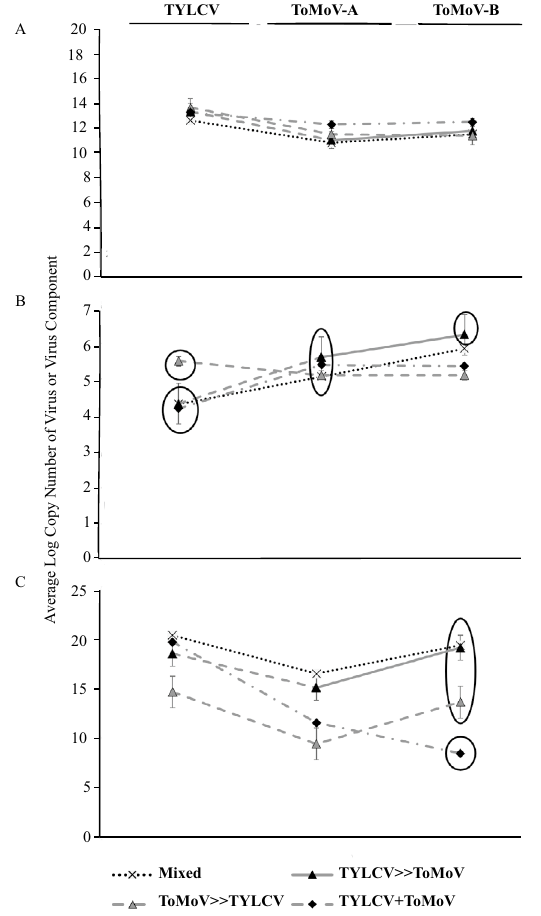
Figure 2. The average log 10 copy number of TYLCV, ToMoV-A, and ToMoV-B in co-acquisition scenario treatments. Data were analyzed separately for samples in which both TYLCV and ToMoV were detected in ( A ) vector cohorts, ( B ) artificial diet viruliferous vector cohorts fed upon, and ( C ) co-infected plants inoculated with vector cohorts. Copy numbers were compared for the main effects of virus acquisition scenario treatment, virus or viral component, and their interaction term; averages from interaction term main effects are shown. LS means comparisons were conducted using Tukey’s method at P = 0.05. Circled averages are not significantly different from each other by virus/viral component; no circles indicate no differences.